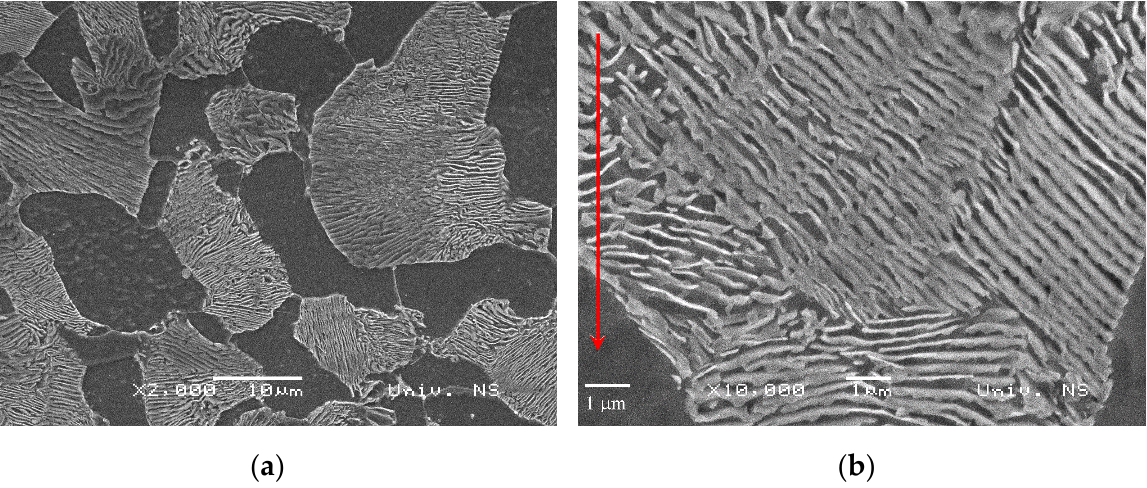
Figure 4. The SEM images of microstructure of undeformed sample: ( a ) ferrite–pearlite structure of base metal (×2000 magnification); ( b ) orientation of cementite lamellae (red arrow—direction of upsetting), ×10000 magnification.